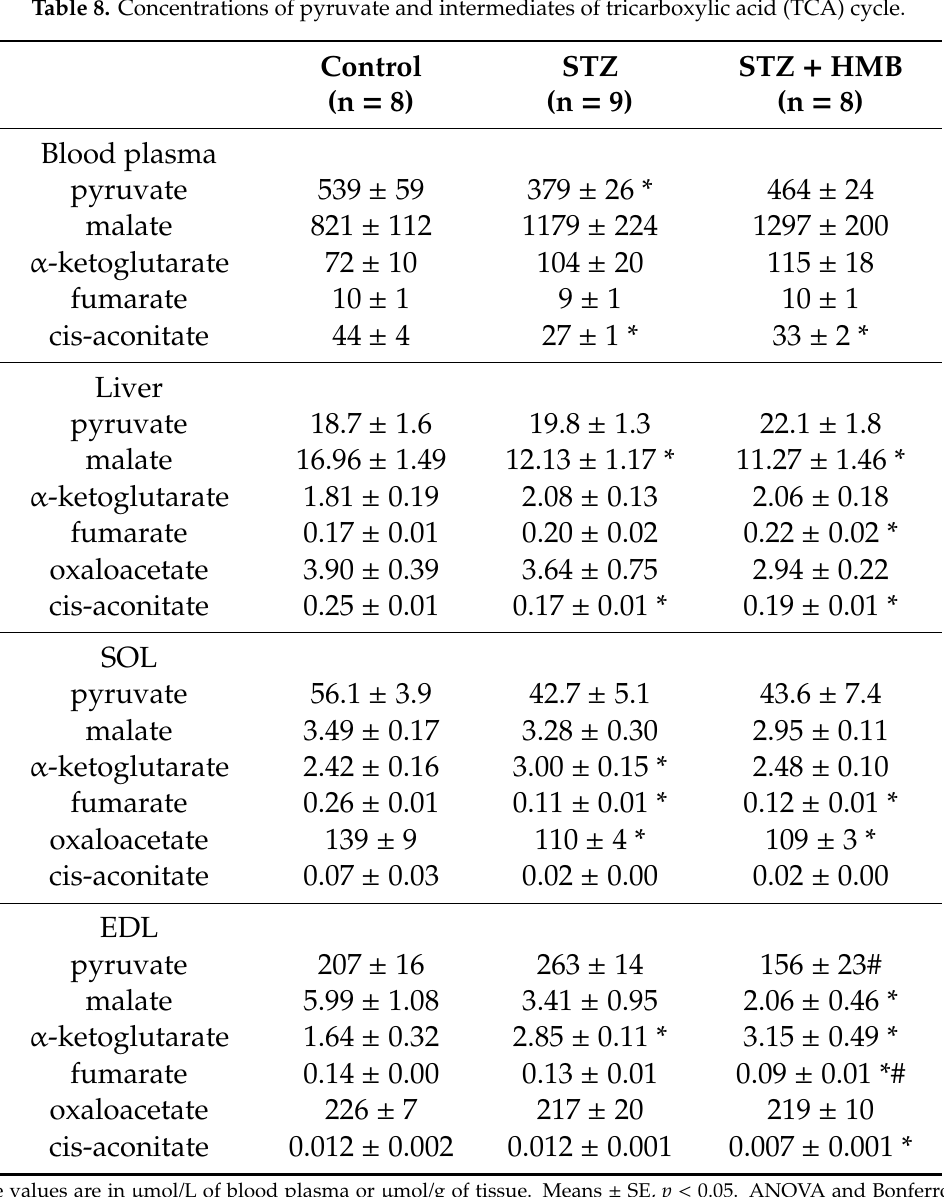
Table 8. Concentrations of pyruvate and intermediates of tricarboxylic acid (TCA)